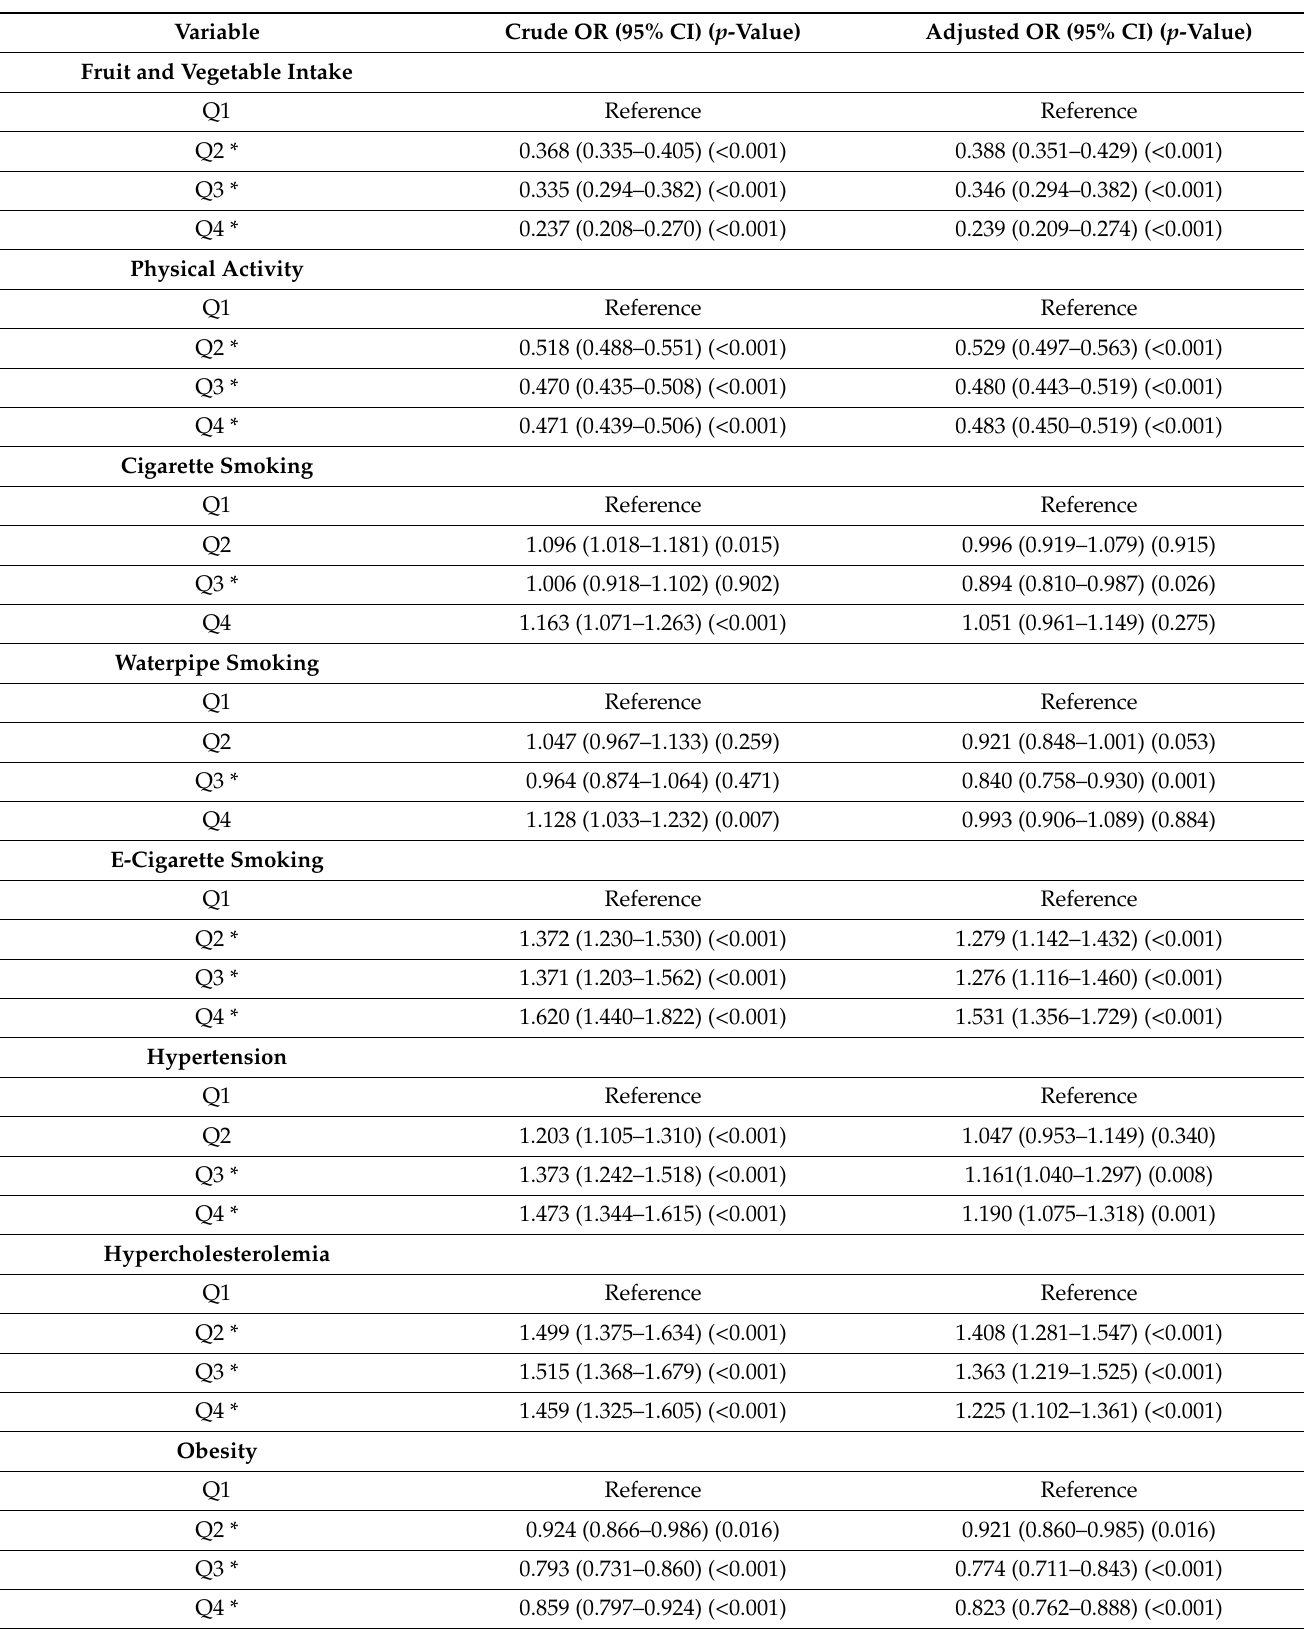
Table 3. Crude and adjusted odds ratios (ORs) of the association between each quarter of 2020 and all risk factors and chronic diseases in the Sharik Health Indicators Surveillance System